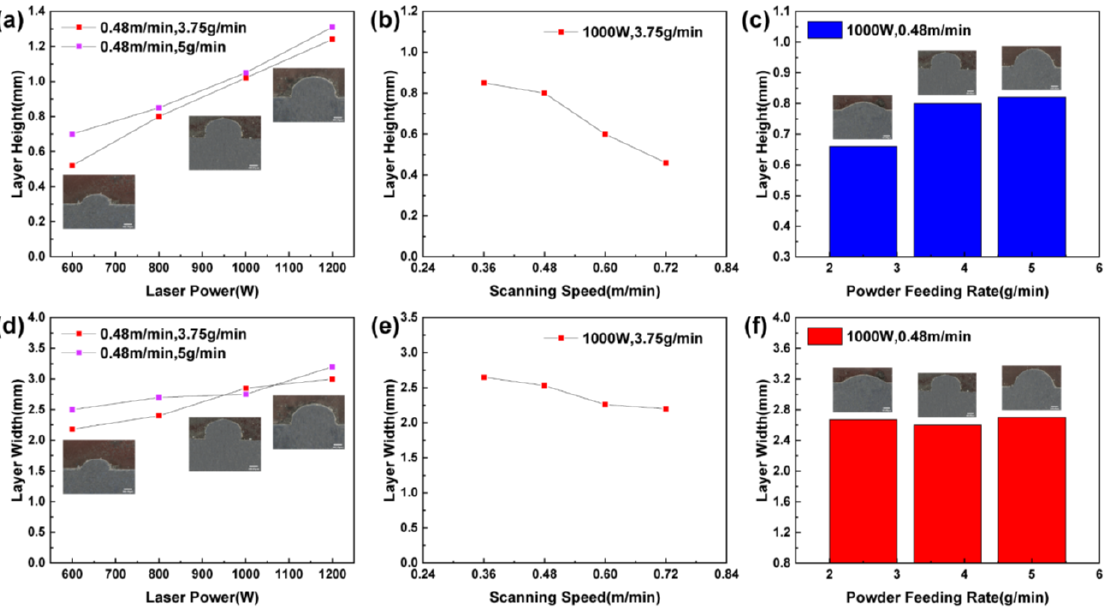
Figure 8. The formation features under different parameters with laser spot diameter of 2.5 mm: ( a ) Laser power and layer height, ( b ) Scanning speed and layer height, ( c ) Powder feeding rate and layer height, ( d ) Laser power and layer width, ( e ) Scanning speed and layer width, ( f ) Powder feeding rate and layer width.